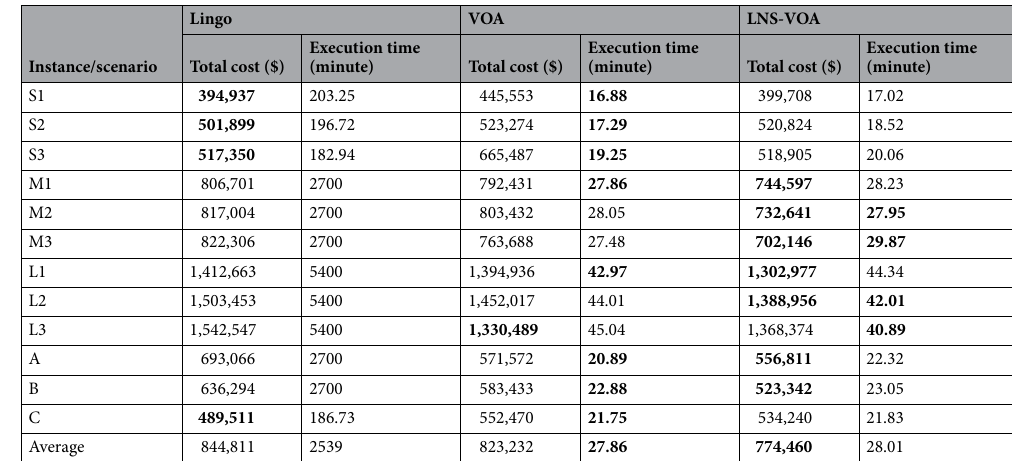
Table 7. The numerical results of the testing instances and all three scenarios. Bold numbers indicate that it is the best result comparing to the results from all algorithms.